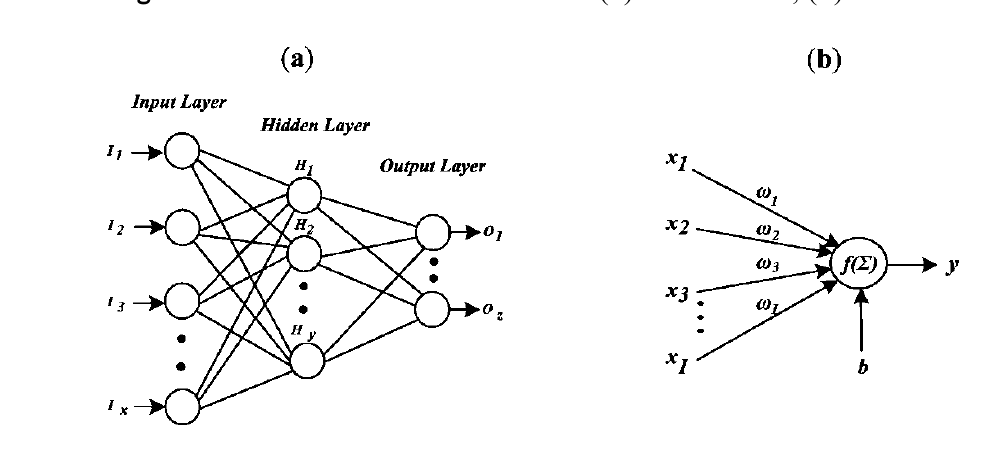
Figure 2. Feed-forward neural network. ( a ) Architecture; ( b )